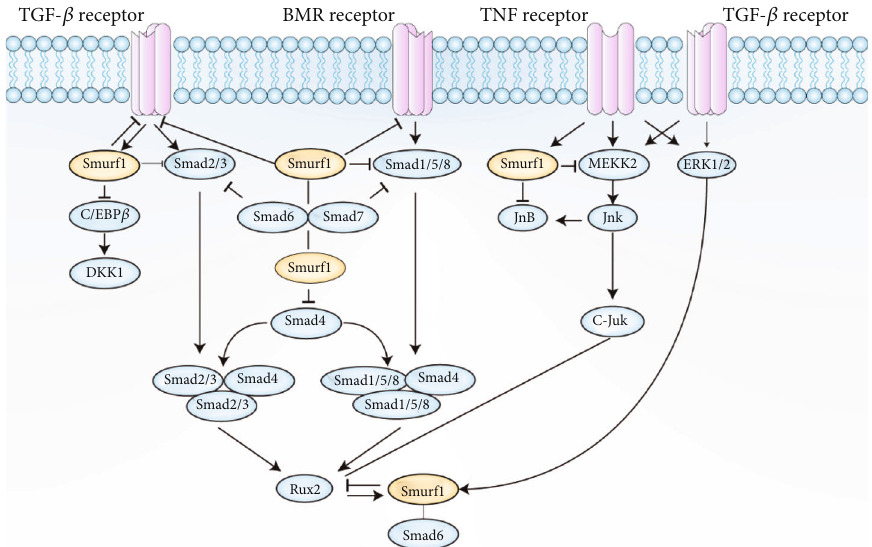
Figure 1: The E3 ubiquitin ligase SMURF1 mediates the ubiquitination and degradation of key factors from BMP/TGF- β pathway, NF- κ B pathway, MAPK pathway, and other pathways, thereby regulating osteogenic di ff erentiation. Notably, these pathways interconnected with each other and formed a complex regulatory